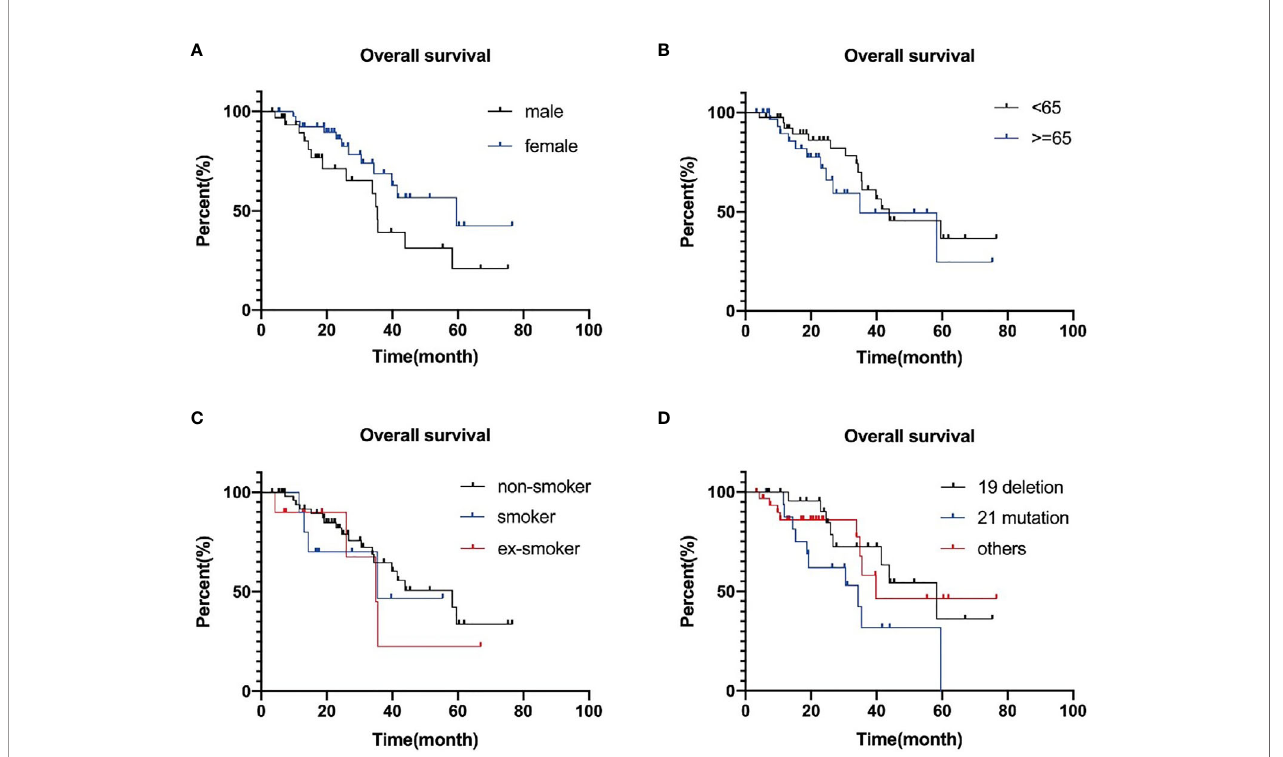
FIGURE 4 | Progression-free survival curves plotted separately by gender (A) , age (B) , smoking (C) , and genotype group (D) . P-values are 0.927, 0.299, 0.126, and 0.923, successively.